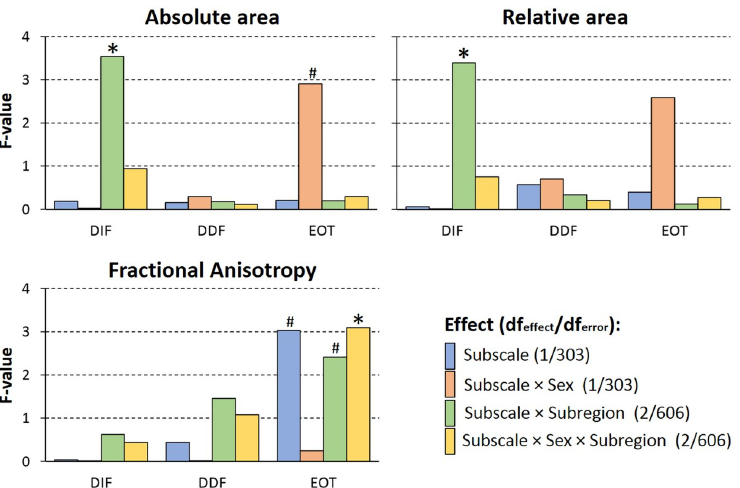
Fig 3. Callosal measures and emotional awareness. Bars represent the F -values for the effects of interest (i.e., main effect of subscale, interaction of subscale with sex and Region, respectively, and the three-way interaction) for the ANCOVAs conducted in the third analysis step. Results are shown separately for the three callosal parameters (panels) and the three TAS subscales (nested plots). Significant effects ( p < .05) are indicated by asterisk ( � ), and trends ( p < .10) by a number sign (#). Post-hoc analyses and effect size are reported in text. All effects common to the performed analyses (i.e., main effect of subregion and sex, as well as the subregion × sex interaction) are not depicted, but followed the same pattern as reported in analysis step